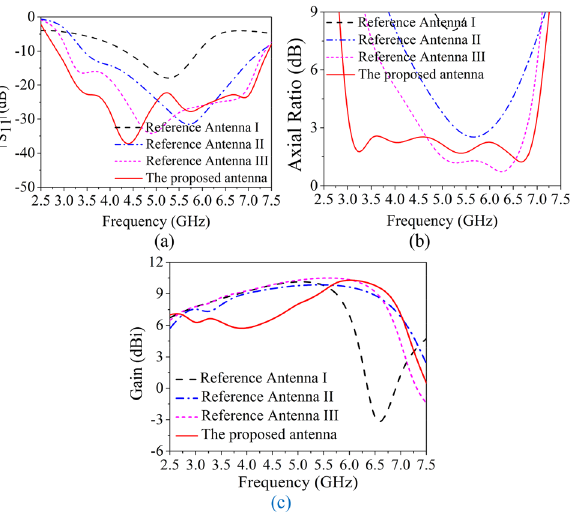
Figure 2. Simulated reflection coefficients, ARs and gain of the antennas. ( a ) Reflection coefficients, ( b ) ARs, and ( c ) gain.